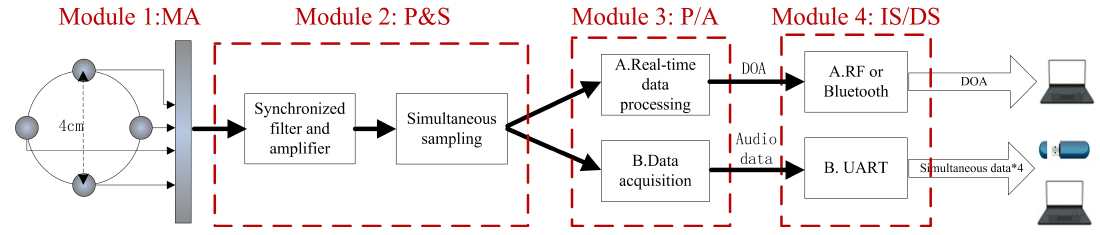
Figure 2. System architecture of the automatic bearing tracking